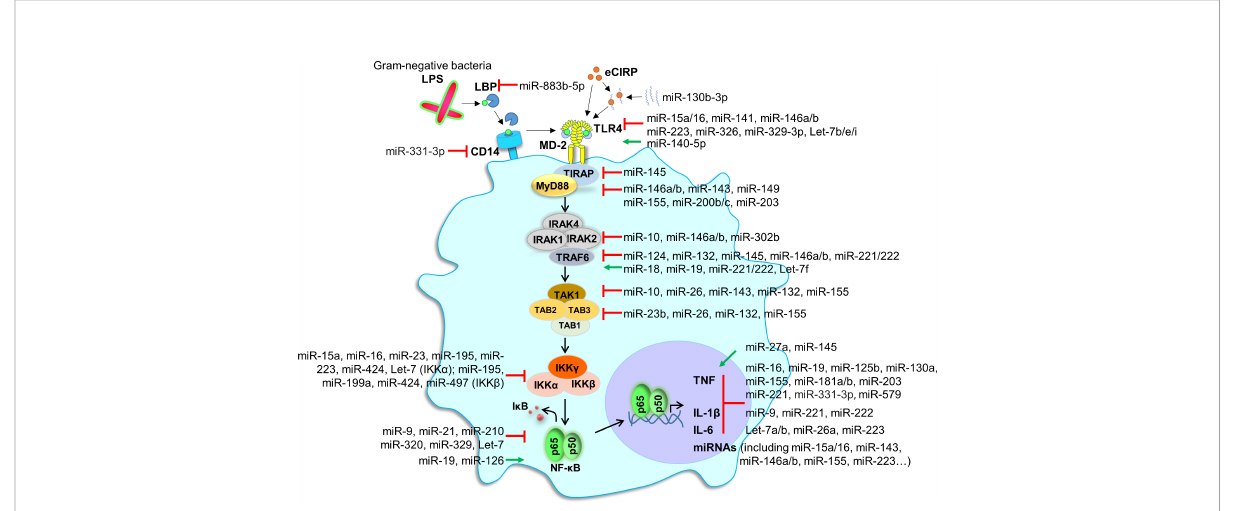
FIGURE 3 miRNAs and endotoxin sensing and signaling. The fi gure shows the recognition and intracellular signaling events following the sensing by monocytic cells of LPS from Gram-negative bacteria. LPS aggregates are dissociated by the LPS-binding protein (LBP). LPS/LBP complexes are transferred to CD14, a glycosylphosphatidylinositol-anchored molecule expressed on the membrane of monocytic cells. CD14 transfers LPS to TLR4 together with MD-2. This induces the recruitment of TIR domain-containing adaptor protein (TIRAP) and myeloid differentiation primary response gene (MyD88). MyD88 is involved in early nuclear factor- k B (NF- k B) activation and pro-in fl ammatory gene expression. NF- k B signaling is involved in the expression of many miRNAs. For reasons of simplicity, we did not depict the TIR domain-containing adaptor inducing IFN b (TRIF)-dependent, MyD88 independent, pathway involved in IRF signaling and late NF- k B activation. Red lines depict inhibition, while green lines depict activation (by miRNAs). eCIRP, extracellular cold-inducible RNA binding protein; I k B, inhibitory kappa B; IKK, I k B kinase; IRAK, IL-1 receptor-associated kinase-1; TAB, transforming growth factor- b (TGF- b ) activated kinase 1; TRAF, TNF receptor-associated factor; TAK1, TGF- b activated